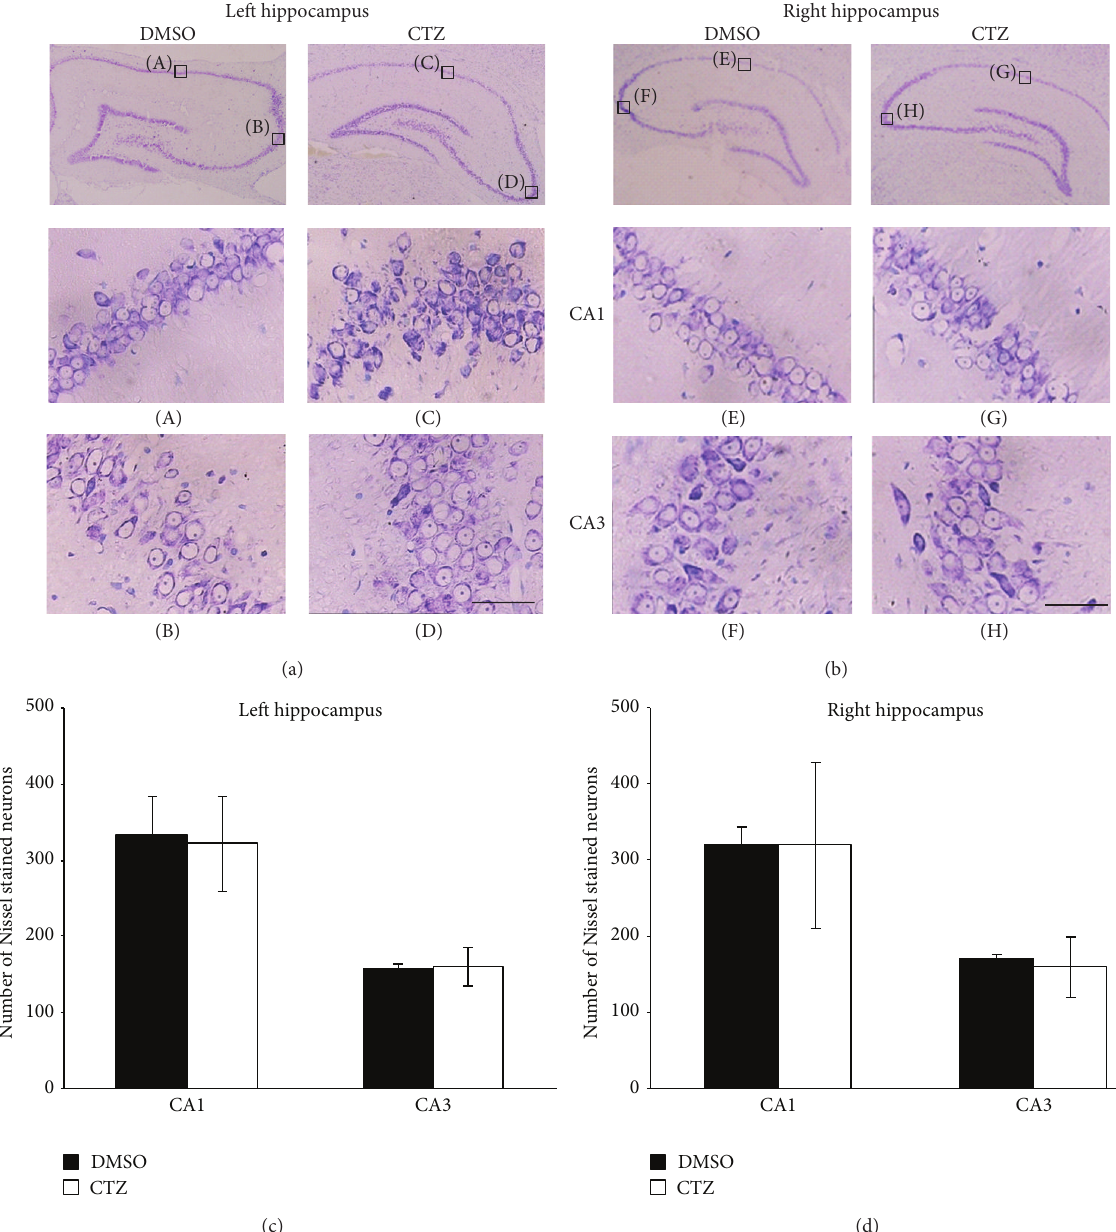
Figure 3: Nissl staining of the hippocampal neurons in chronic CTZ seizure rats 6 months after seizure induction. (a-b) Pictures showing the Nissl staining of the left (a) and right (b) hippocampus of either DMSO or CTZ treated rats. The expanded pictures (A–H) showing the detail of the Nissl stained hippocampal CA1 and CA3 neurons. (c-d) Group data of the counted Nissl stained hippocampal neurons in left (c) and right (d) hippocampus of either DMSO or CTZ chronic seizure rats. Scale bar = 50 𝜇